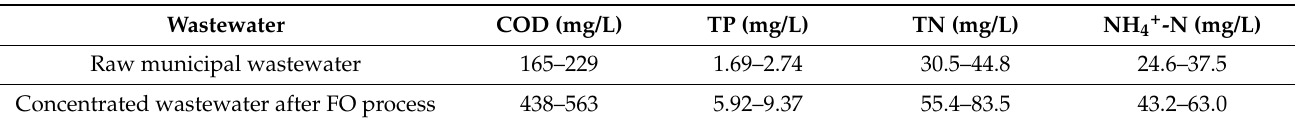
Table 2. The physicochemical properties of raw municipal wastewater and concentrated wastewater after the FO process